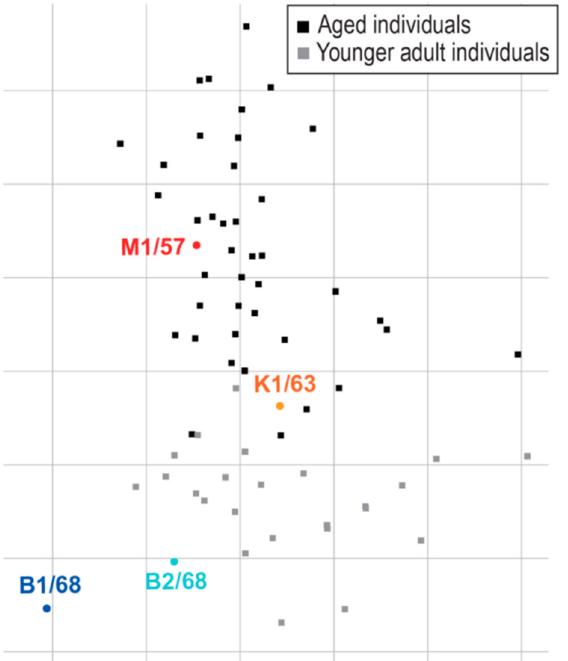
Figure 3. An antigenic map of human H2N2 viruses. An antigenic map was generated from the neutralization data shown in Table 2. Viruses are represented as circles and plasma samples obtained from aged or younger adults are represented as black or grey squares, respectively. Sera with no or only 1 numerical antibody titer are not shown as they cannot be placed properly in an antigenic map. The grid indicates one unit of antigenic distance, a two-fold dilution in neutralization titer. Table 3. Comparison of amino acids that are important for HA antigenicity a. Amino Acid Position at Isolate 126